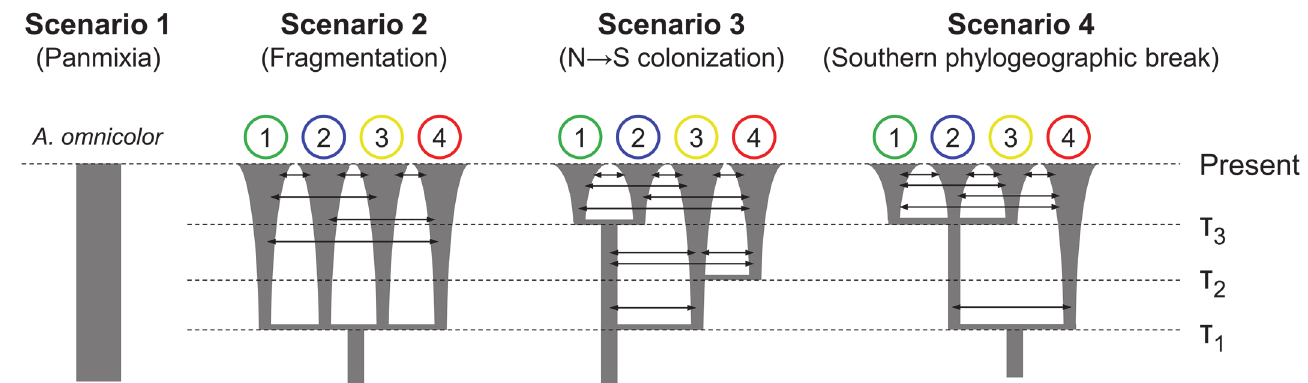
Fig 2. Alternative demographic scenarios for Araneus omnicolor . Scenario 1: panmictic population; scenario 2: single fragmentation event partitioning the ancestral population into geographically separated patches; scenario 3: southward colonization; scenario 4: southern phylogeographic break. Only the highest-probability models in each scenario are shown (see results). Numbers above branches indicate geographical regions; arrows and expanding branches represent migration and exponential population growth, respectively. τ = divergence/expansion times (see Table 1).